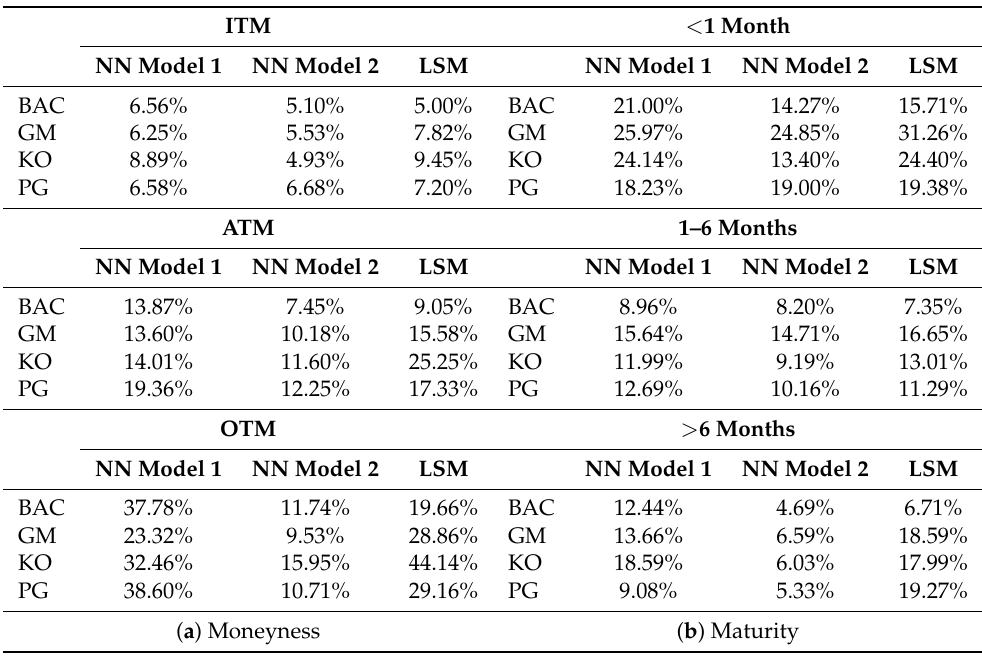
Table 8. Relative RMSE per company: moneyness and maturity.